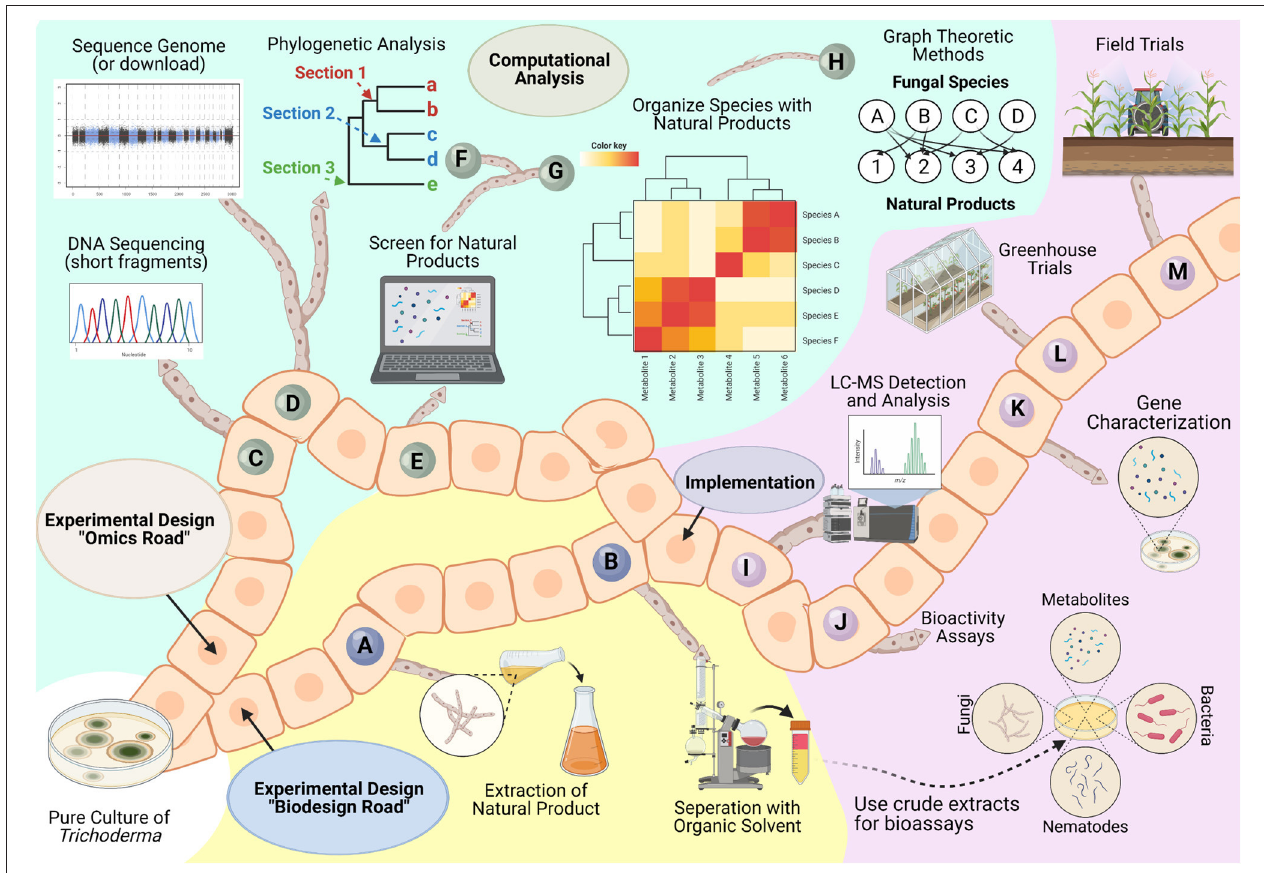
FIGURE 10 | Roadmap for bioprospecting Trichoderma for natural products. Isolation of an axenic Trichoderma isolate is needed to initiate the roadmap. The biodesign road details the following general steps to extract and experimentally screen bioactive compounds: (A) Grow the culture in a liquid broth medium and collect the supernatant by filtration; (B) Use an appropriate organic solvent (e.g., ethyl acetate, methanol, etc.) to extract metabolites present in the filtrate. This crude exudate is composed of a mixture of natural products that can be further interrogated to identify targeted bioactivity properties. To predict putative natural products before extensive laboratory studies, then the “omics” road can be followed using the following steps: (C) Extract genomic DNA from the isolate and determine the species identity by amplifying and sequencing genetic markers like the internal transcribed spacer region (ITS), elongation factor 1-alpha ( tef1 ), and RNA polymerase II subunit ( rbp2 ) (Cai and Druzhinina, 2021); (D) Sequence reference genome of isolate; (E) Predict natural products using tools such as antiSMASH or amPEPpy. With this information, (F ) comparative genomic analyses can be performed to determine which taxonomic section the target isolate belongs to, and (G,H) can be used to relate predictions across organisms to highlight the uniqueness and diversity of putative natural products across available Trichoderma by using graph theory. Both roads are led to an implementation step where experimental design aims to (I) selectively characterize predicted or isolated compound(s) by liquid or gas chromatography coupled to mass spectrometry, (J) evaluate bioactivity for selected compound(s), (K) determine the genes and proteins responsible for the production of the compound(s), (L) conduct trials to determine its potential usefulness in greenhouse conditions, and (M) test the compound effects in field trials.